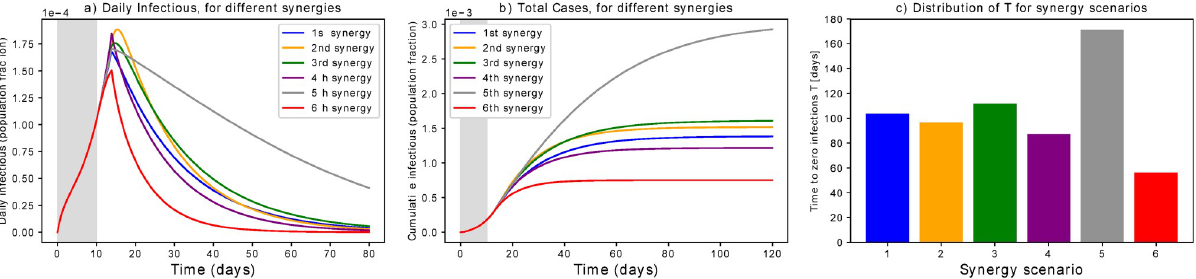
Fig 8. Synergistic scenarios. Simulations of the 6 synergistic scenarios. (a) Curves of infectious Individuals, (b) Cumulative cases. The grey area indicates when measures are not yet in place. It is evident that scenarios leading to similar ^ R could show different patterns and mitigation timing. (c) Distribution of times to zero infections T for different scenarios.